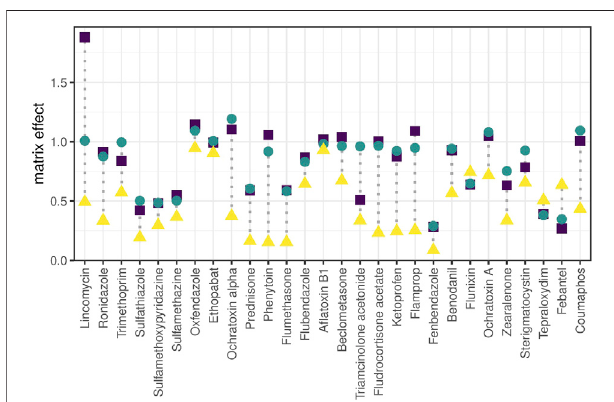
FIGURE 5 | Matrix effect. Matrix effect is calculated for exogenous compounds as the calibration curve slope (linear range) obtained for spiked plasmaextractrelativetotheslopeobtainedforpuresolvent.Ratio < 1:matrix- related ion suppression, ratio > 1: matrix-related signal enhancement, ratio = 1: signal intensity was not in fl uenced by matrix effects. Molecules are ordered from low to high retention time (left to right).